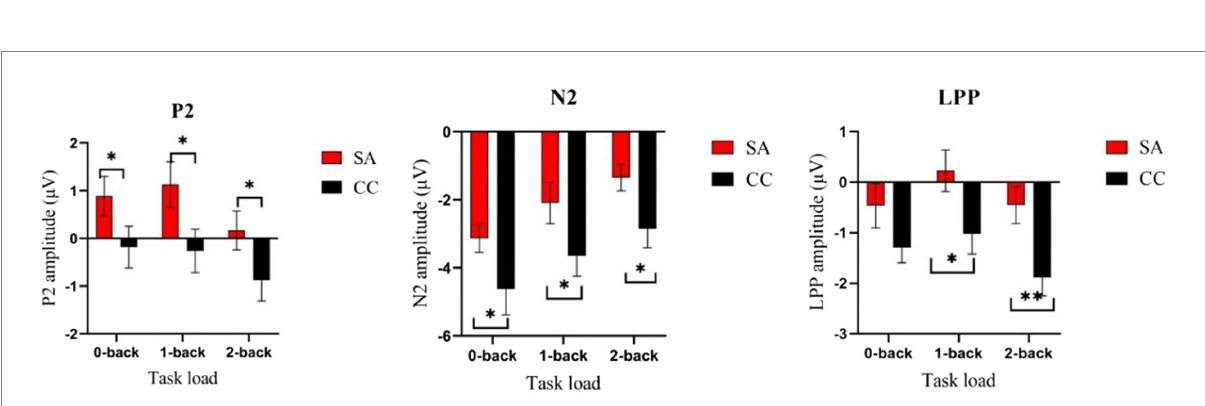
FIGURE 4 Comparison of amplitudes of P2, N2, and LPP in n-back task under self-awareness and control groups. Error bar represents the standard error. * p < 0.05; ** p < 0.01. The self-awareness group evokes larger P2/LPP than the control group. The control group evokes larger N2 than the self-awareness group. Red rectangle represents participants of self-awareness group (SA), and black rectangle represents participants of control group